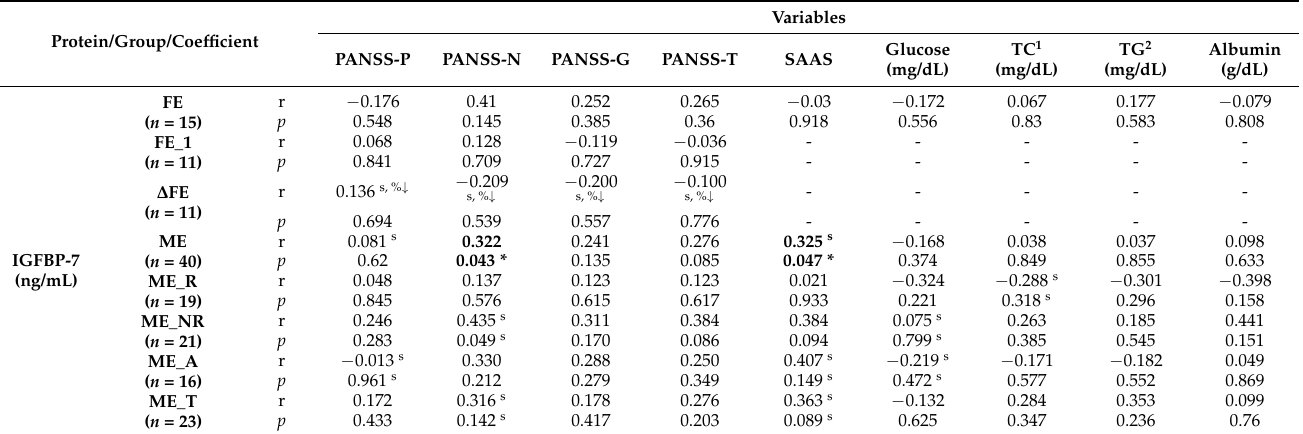
Table 3. Correlation between IGFBP-7 and variables.